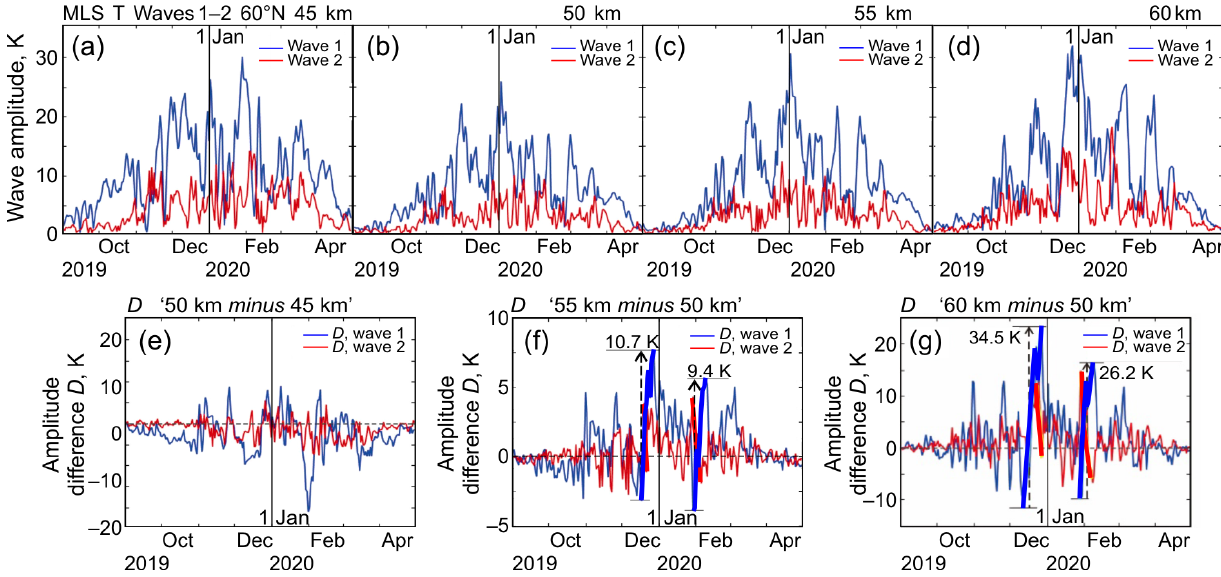
Figure 4. Amplitudes of wave 1 and wave 2 at 60° N ( a ) below stratopause (45 km), ( b ) at mean climatological stratopause height (50 km), and ( c , d ) above stratopause (55 km, 60 km); ( e – g ) difference D between wave amplitude at ( e ) 50 km and 45 km, ( f ) 55 km and 50 km, and ( g ) 60 km and 50 km. Thickened parts of the blue (red) curve in ( f ) and ( g ) show rapid wave-1 (wave-2) amplitude increase (decrease) with altitude.